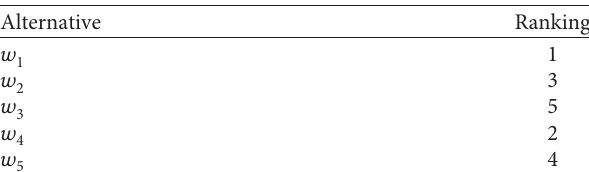
Table 37: Tabular representation of revised closeness index of each